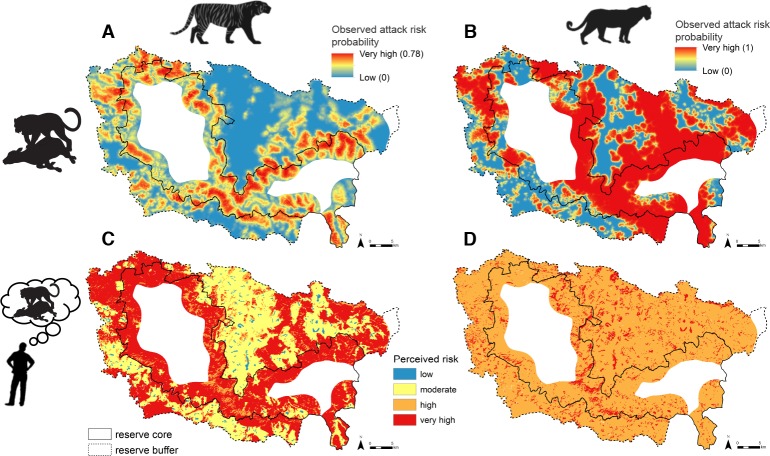
Maps showing model predictions of observed attack risk (top, A and B) and livestock owners’ perceptions of attack risk (bottom, C and D) for tiger (left, A and C) and leopard (right, B and D) on livestock. Maps represent relative probabilities of risk; absolute magnitudes of risk are not directly comparable.